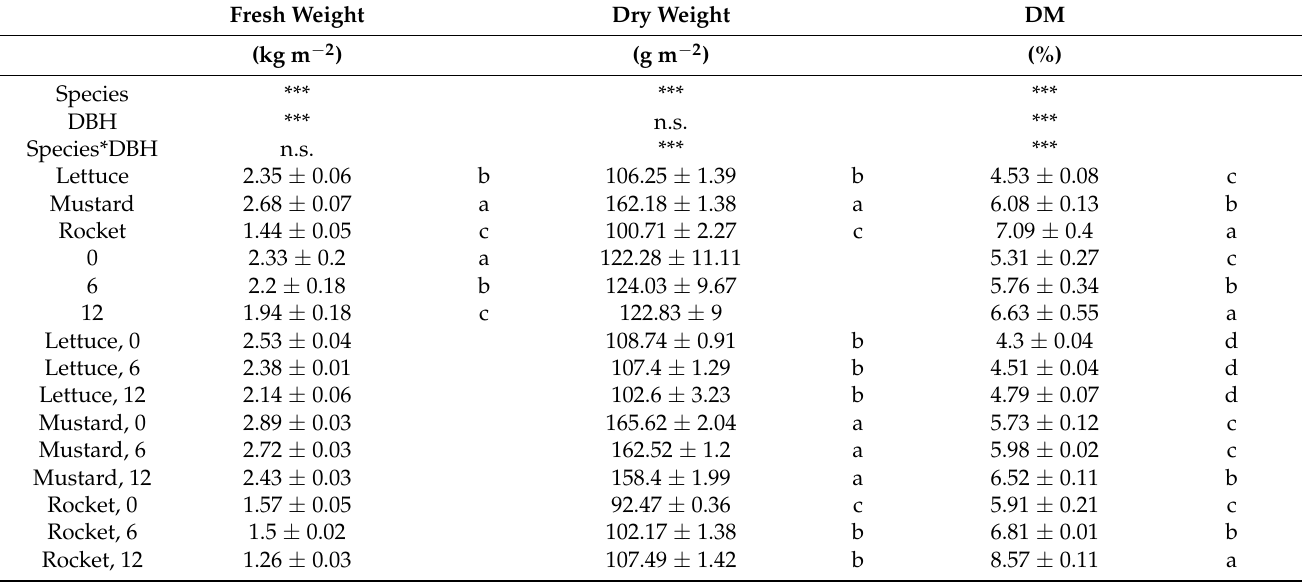
Table 1. Yield attributes of three microgreen species (lettuce, mustard, and rocket) in response to nutrient deprivation treatment (DBH) applied for 6 or 12 days before harvest. All data are expressed as mean ± standard error, n =